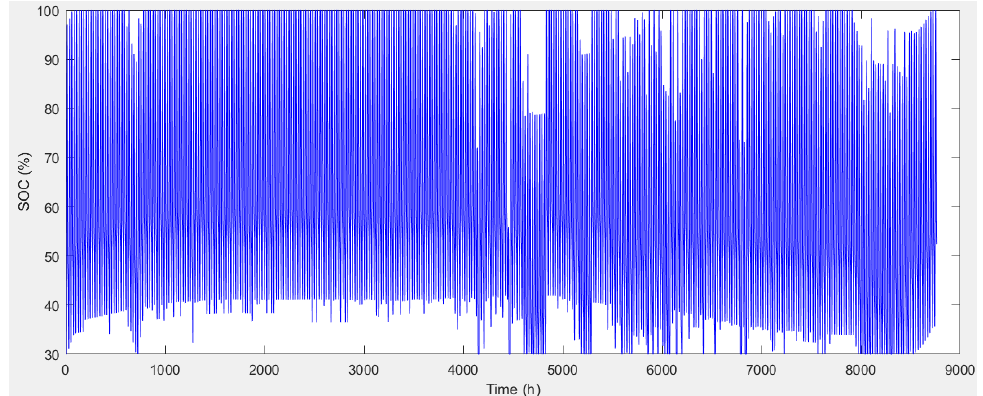
Figure 9. The hourly profile of the SOC of the battery bank during the simulation year.